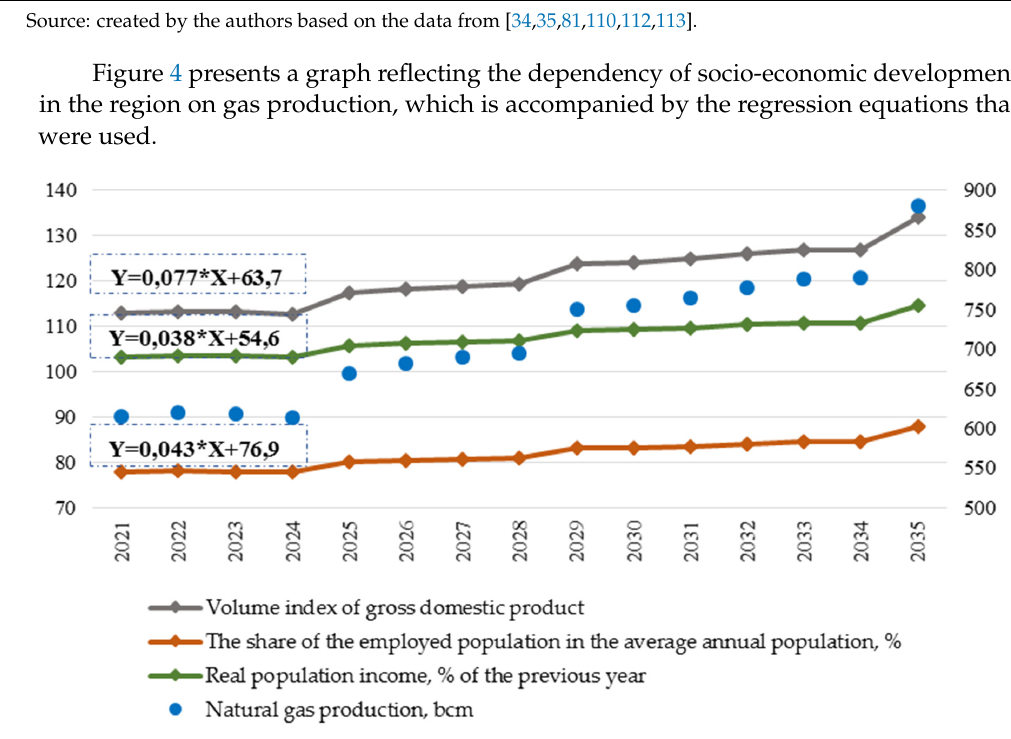
Figure 4. Forecast of changes in the indicators of socio-economic sustainability of the development of oil and gas resources in the Yamalo-Nenets Autonomous Okrug taking into account changes in gas production. Source: created by the